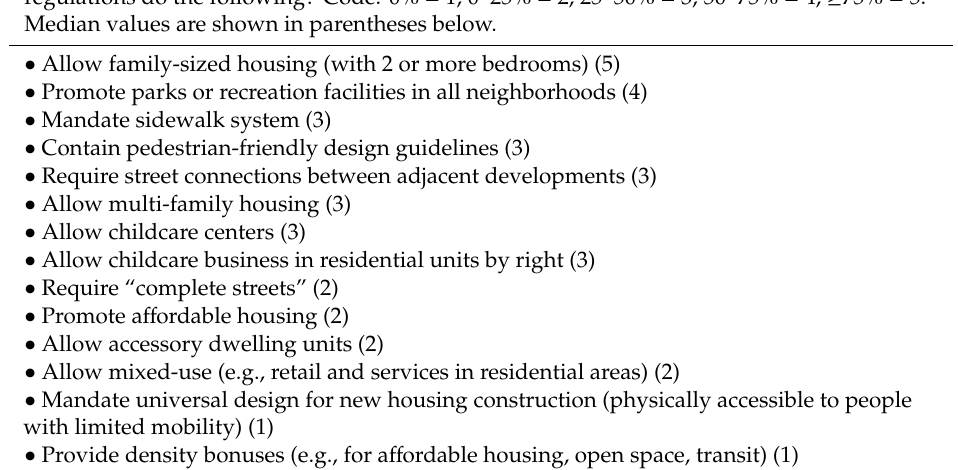
Table 1. Child-friendly Zoning